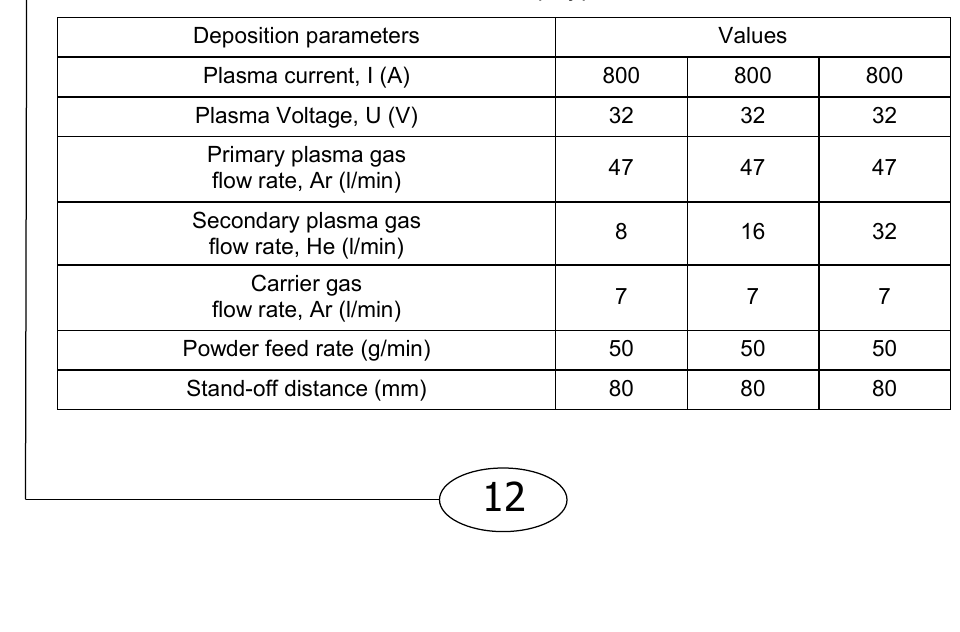
Tabela 1 – Plazma-sprej